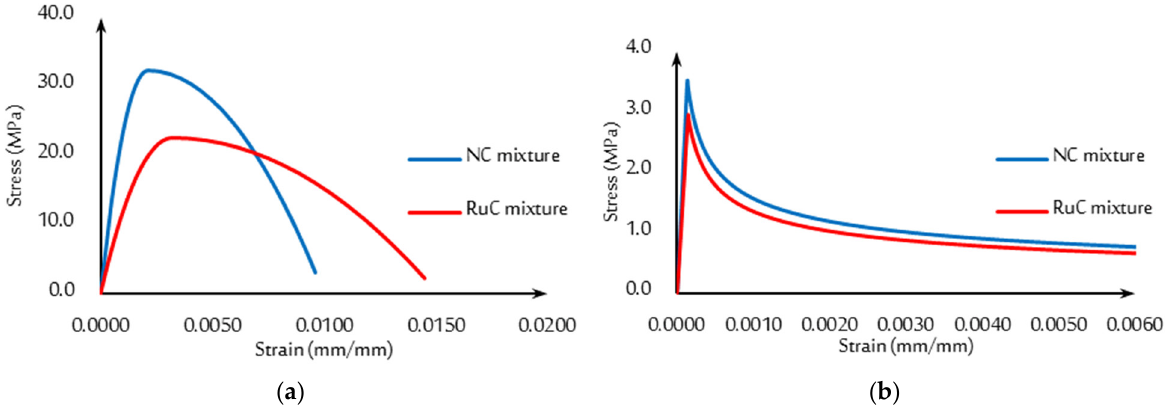
Figure 6. Stress–strain curves of NC and RuC mixtures: ( a ) compression behavior and ( b ) tension behavior.